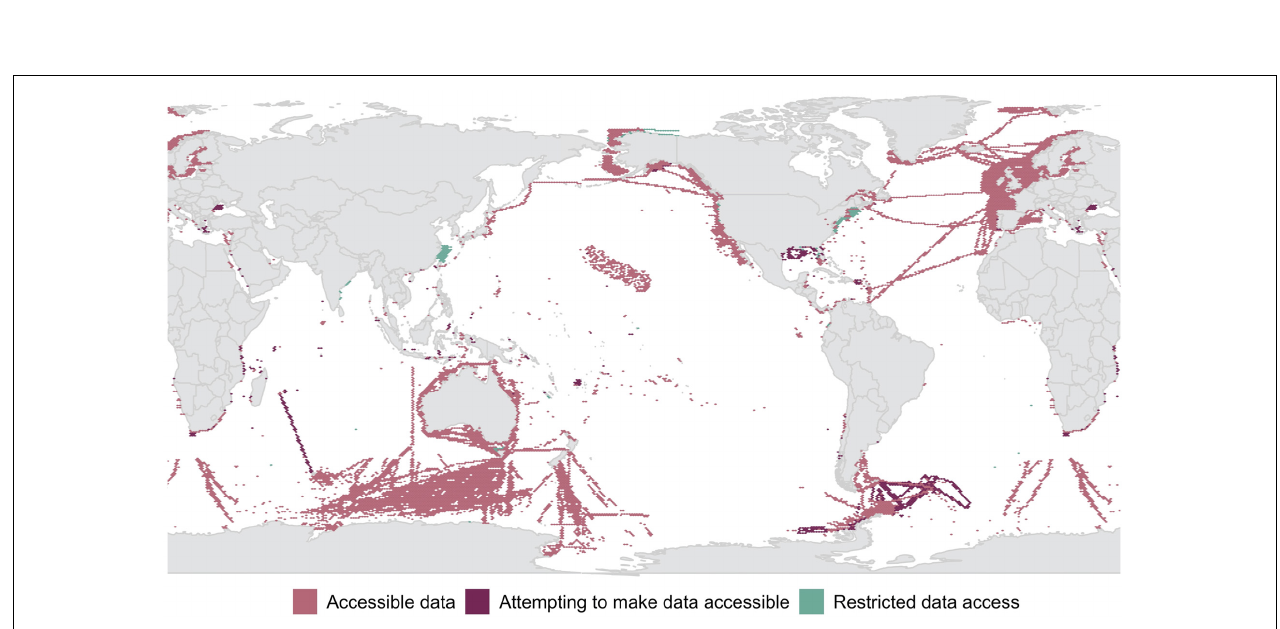
FIGURE 6 | Spatial coverage of the 192 observing programs surveyed that had detailed spatial data and were currently active, had been sampling for 5 or more years, and sampled at least one EOV systematically (map displayed across ≥ 0.5 ◦ grid cell: about 55 km 2 at the equator). Color differentiates data access, including data that are accessible whether publicly available online or accessible by request (pink), programs that are attempting to make data accessible (purple), and programs that have restricted data access (teal).